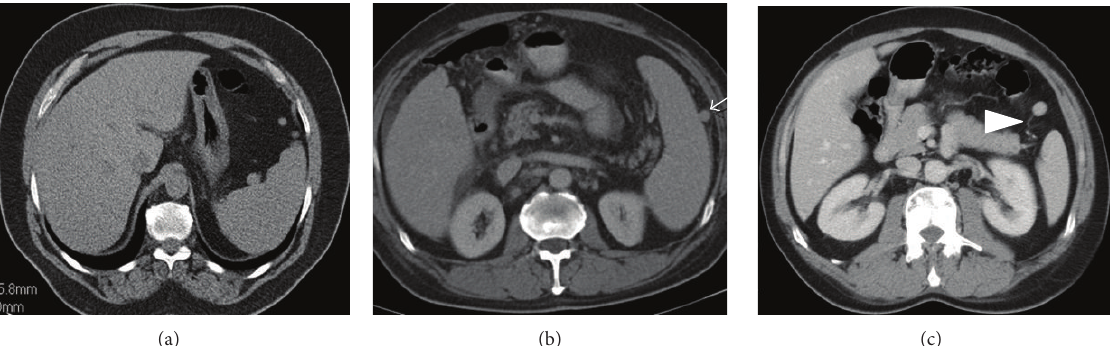
Figure 3: Axial nonenhanced (a) and contrast enhanced (b, c) images show accessory spleens in three different patients. In (a), a 51-year-old male patient has three accessory spleens which are located at splenic hilum and anterior to the spleen. In (b), a 59-year-old male patient has an accessory spleen located at the lateral aspect of the spleen (arrow). In (c), a 50-year-old male patient has an anteriorly located accessory spleen; note its vascular supply originating from splenic artery